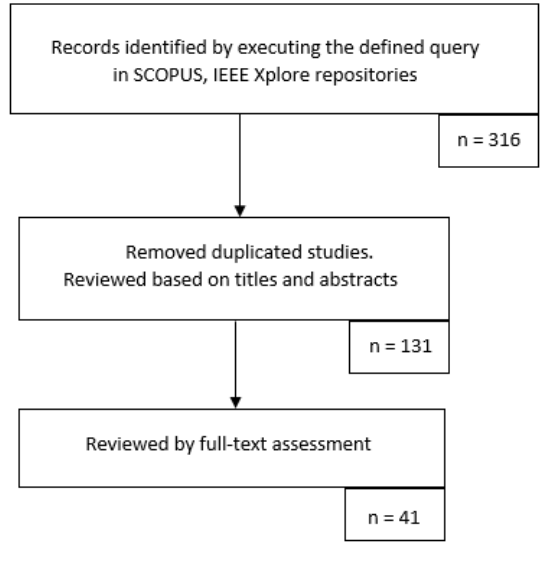
Figure 1. Review